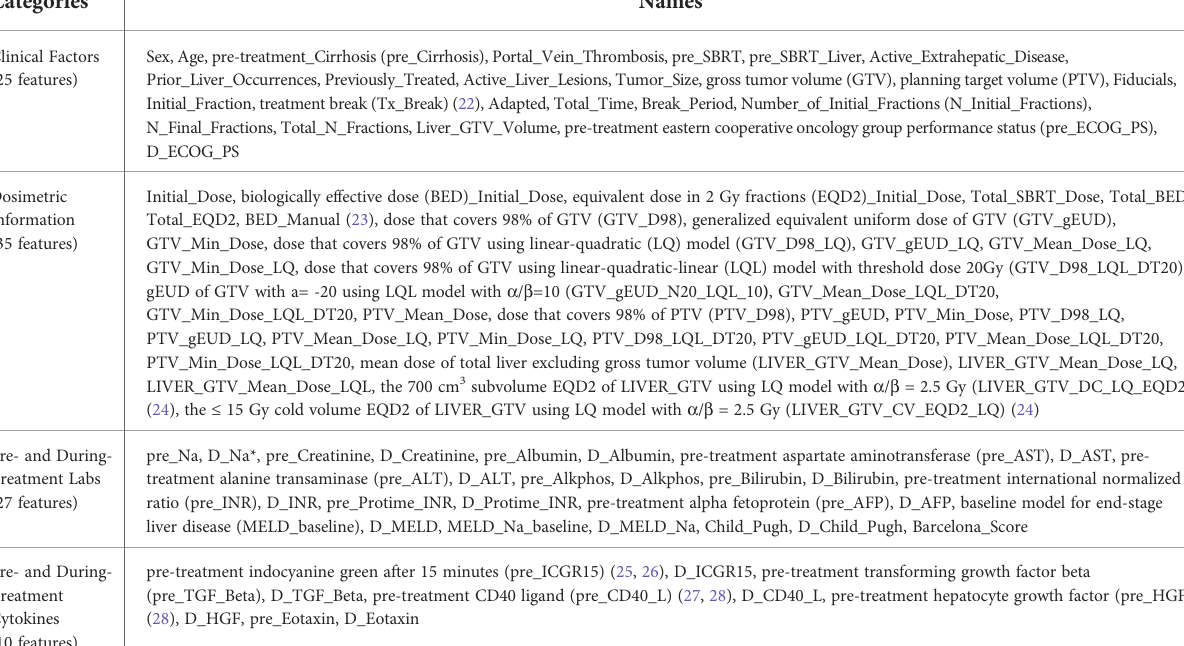
TABLE 1 Features of HCC patients with SBRT in the discovery